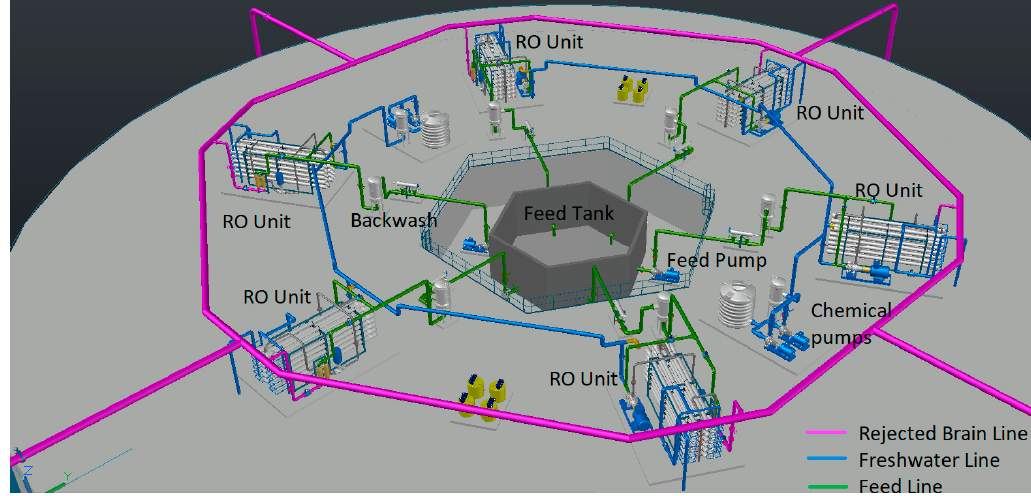
Figure 17. Desalination system arrangement.